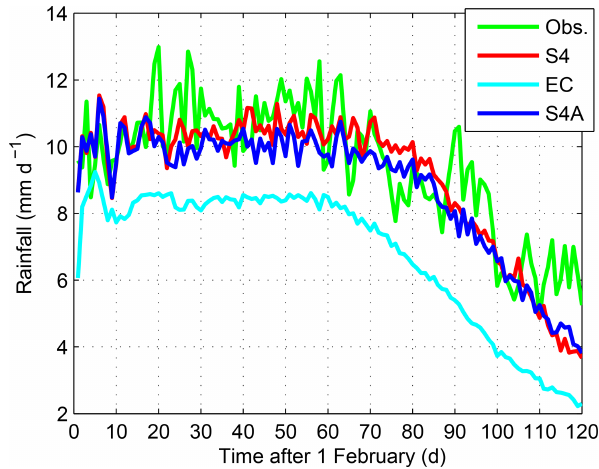
Figure 8. Time series of region-mean rainfall over latitudes 0– 10 ◦ S and longitudes 70–50 ◦ W, through the first 120d of the hind- casts initialised in February. Observed (TRMM) rainfall is shown in green; the models are shown in red, blue and cyan. Full-year ranges of rainfall data are used (see caption of Fig.